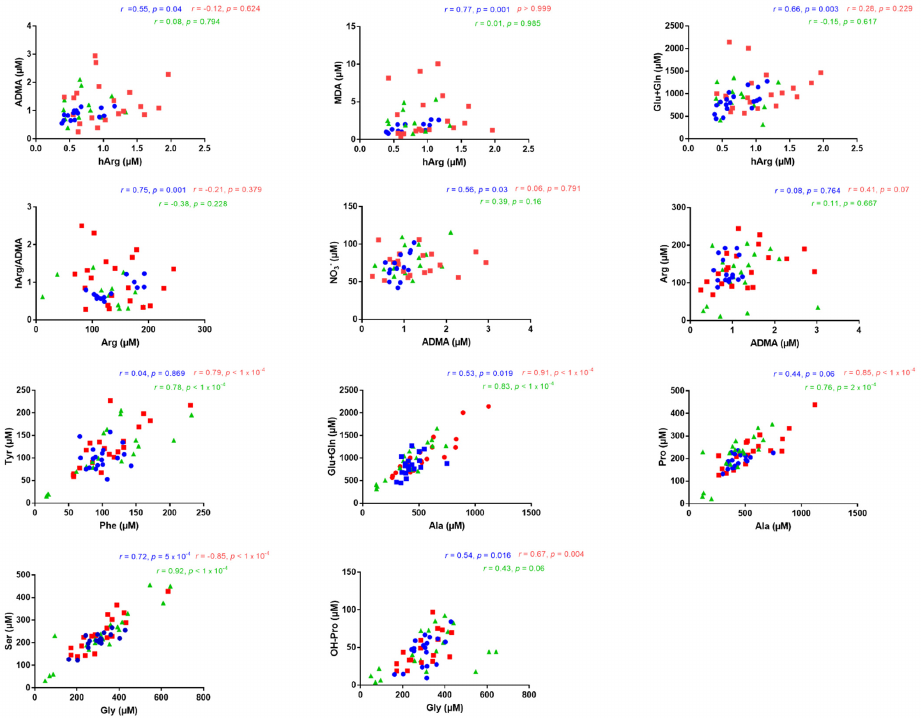
Figure 3. Illustration of statistically significant correlations ( r > 0.4, p < 0.05) found between the serum concentrations of the indicated metabolites in Group A (surgical treatment) (blue), in Group B (conservative treatment) (red) and in Group C (control group) (green). Pearson or Spearman correlation was performed depending on data distribution.